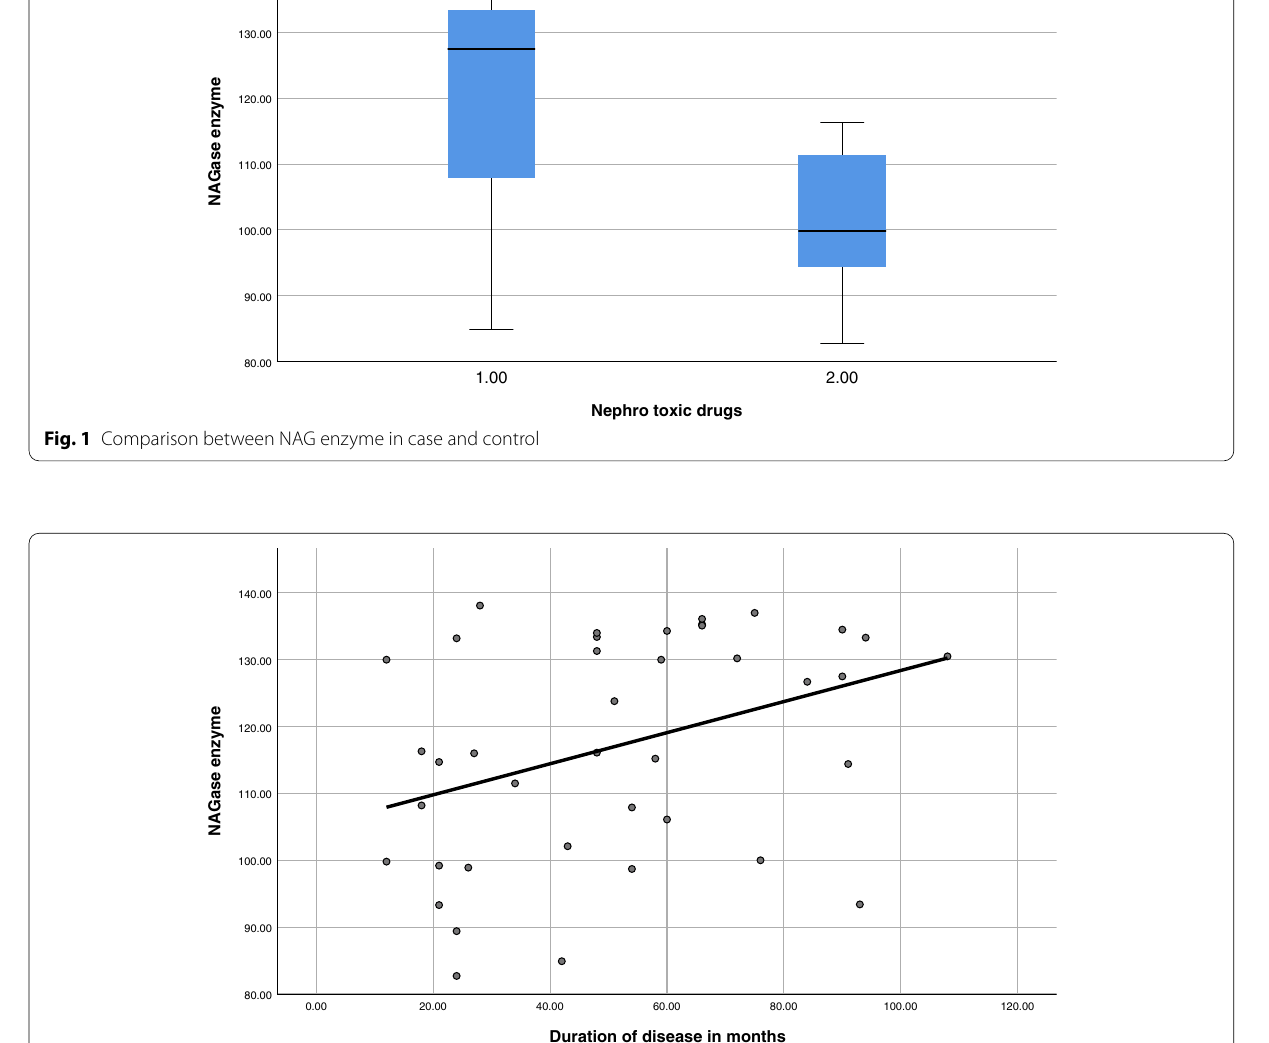
Duration of disease in months =